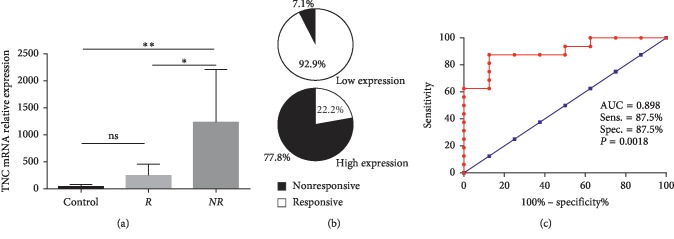
Mucosa TNC mRNA levels are associated with response to infliximab therapy in UC patients. (a) mRNA levels of TNC in control, responsive (R), and nonresponsive (NR) group; (b) rates of responsive or nonresponsive to infliximab in patients with low or high TNC expression; (c) receiver operating characteristic (ROC) curves illustrating the specificity and sensitivity in mucosa TNC levels to differentiate infliximab responsive or nonresponsive for UC. ∗P < 0.05 and ∗∗P < 0.01.